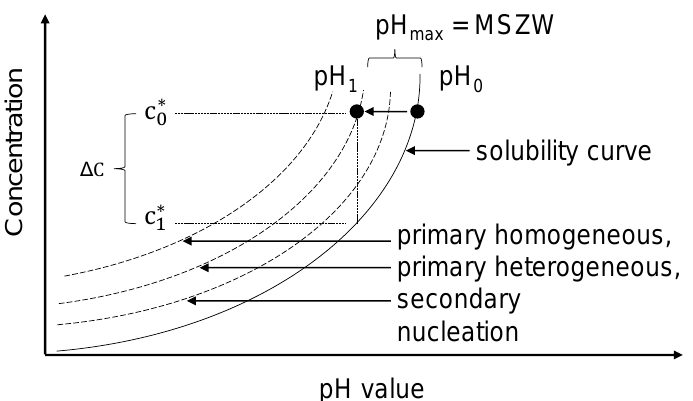
Figure 2. Metastable zone width and nucleation theory adapted to electrochemically induced pH-shift crystallization